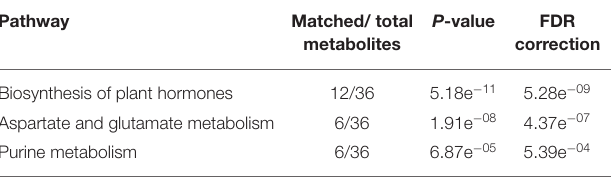
TABLE 2 | Results of metabolic pathway enrichment analysis. Pathway Matched/ total